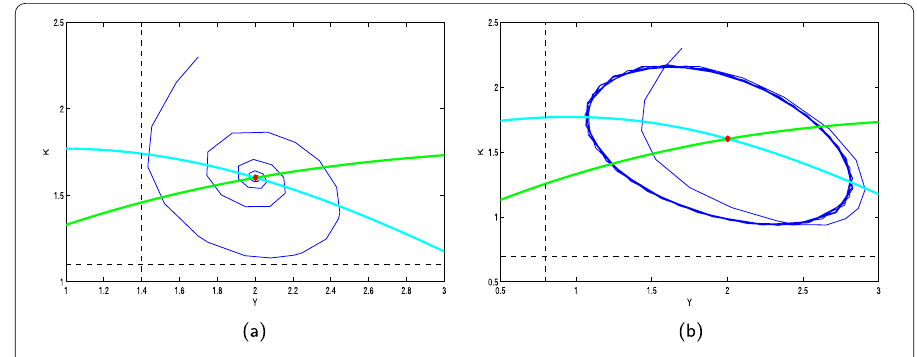
Figure 7 ( a ) τ 1 = 1.9 and τ 2 = 3.6, the positive equilibrium is asymptotically stable. ( b ) τ 1 = 1.9 and τ 2 = 5.02, a periodic solution appears near the positive